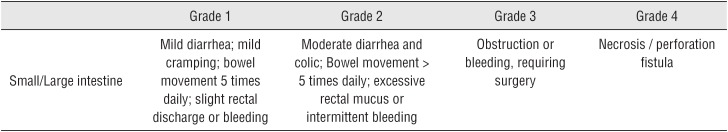
RTOG score, used to evaluate late rectal toxicity (> 3 months). In St Lucas, only 2.8% of the patients had rectal toxicity, none higher than grade 2.